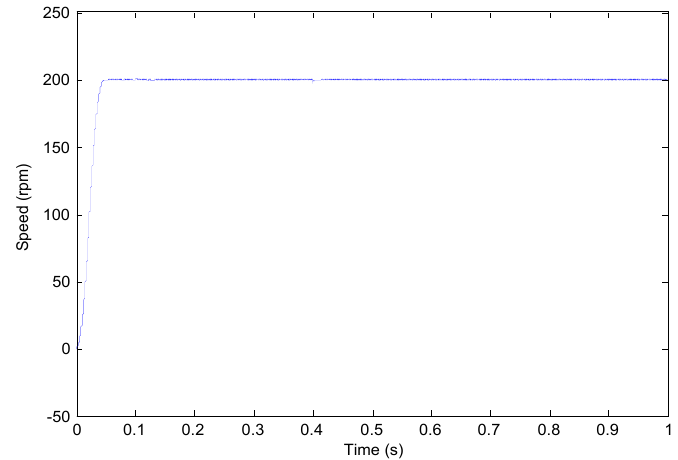
Figure 8. Simulation of the revolution speeds of the motor using active disturbance rejection control (ADRC).